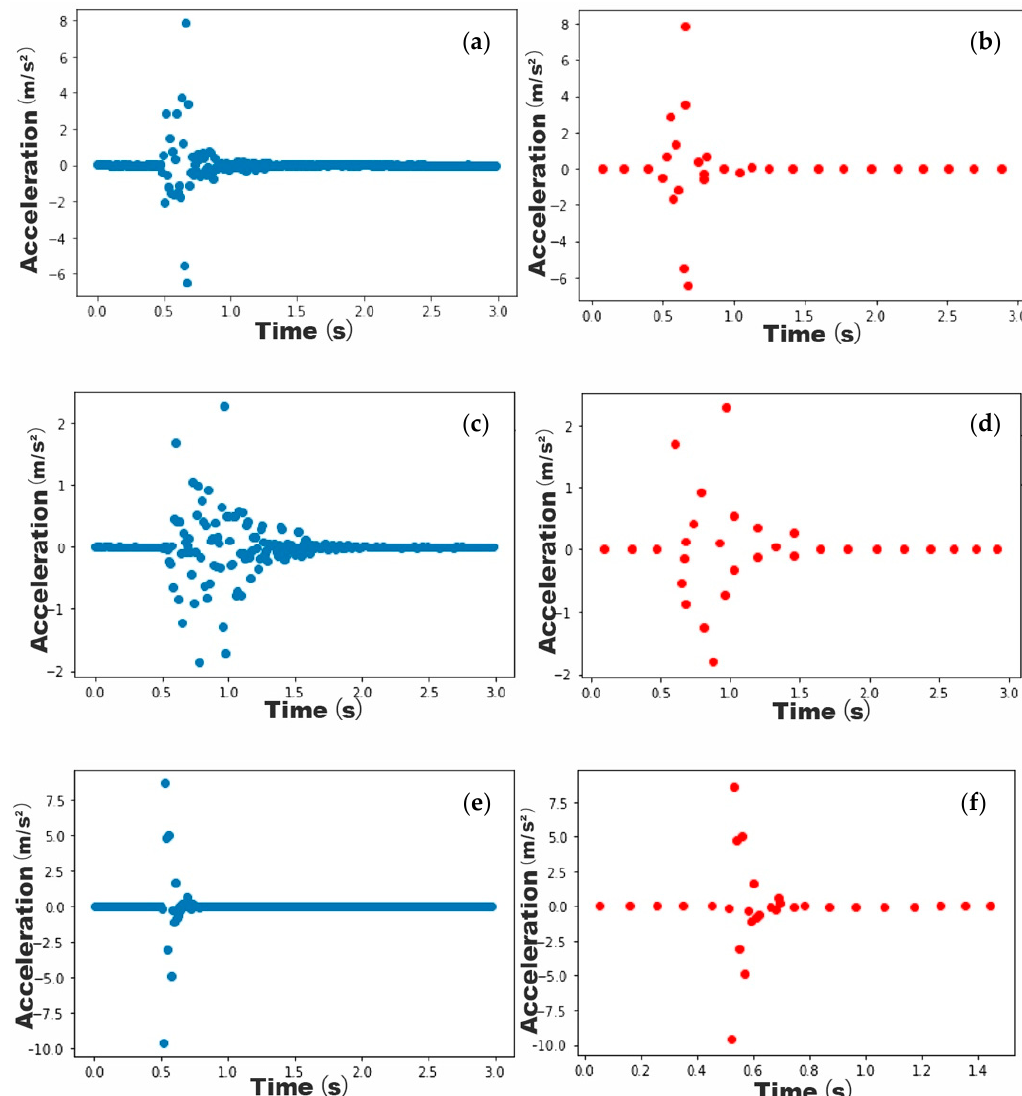
Figure 10. Pattern generation when K = 30. ( a ) Original pattern of human forward fall; ( b ) Simplified pattern of human forward fall; ( c ) Original pattern of human backwards fall; ( d ) Simplified pattern of human backwards fall; ( e ) Original pattern of object drop; ( f ) Simplified pattern of object drop.